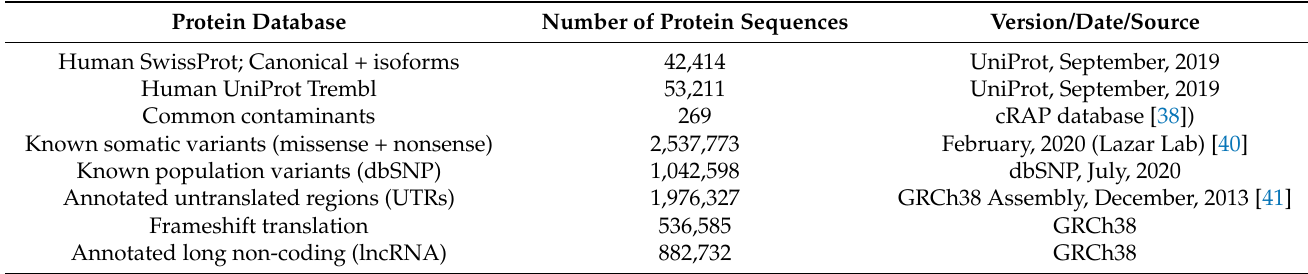
Table 1. A summary of the protein sequences utilized in this